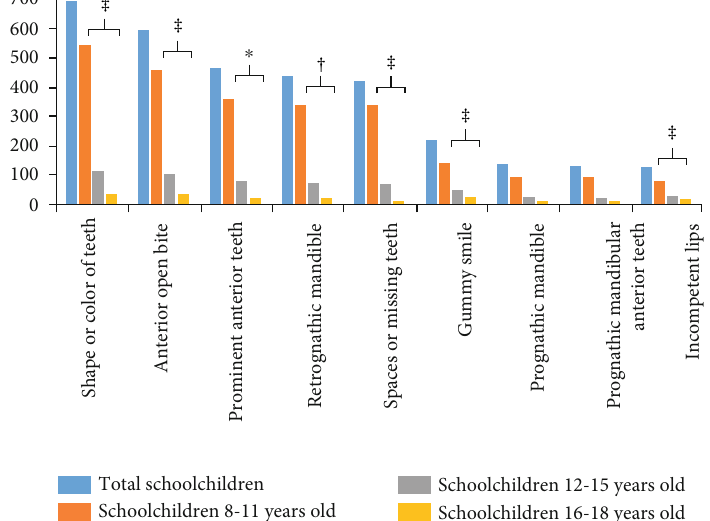
Figure 4: Frequency distribution of dentofacial features reported as targets for victimization according to age group. ∗ p < 0 : 05 , † p < 0 : 01 , and ‡ p < 0 : 001